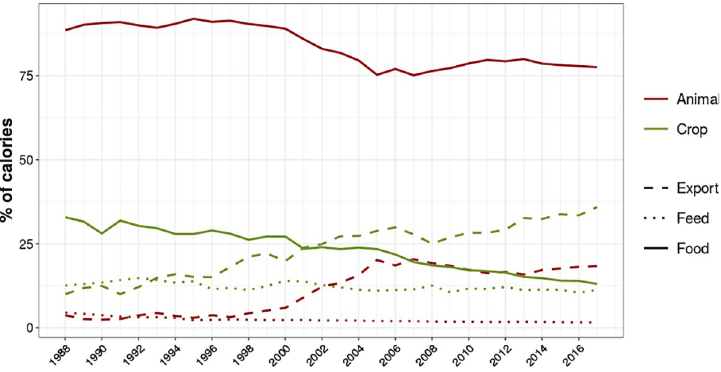
Fig 1. Caloric production in Brazil from 1988 to 2017. Animal (red) and crop (green) calories sum 100% each, disaggregated into calories for export (dashed lines), domestic food consumption (solid lines) and animal feed (dotted lines). Wastes and other uses are not